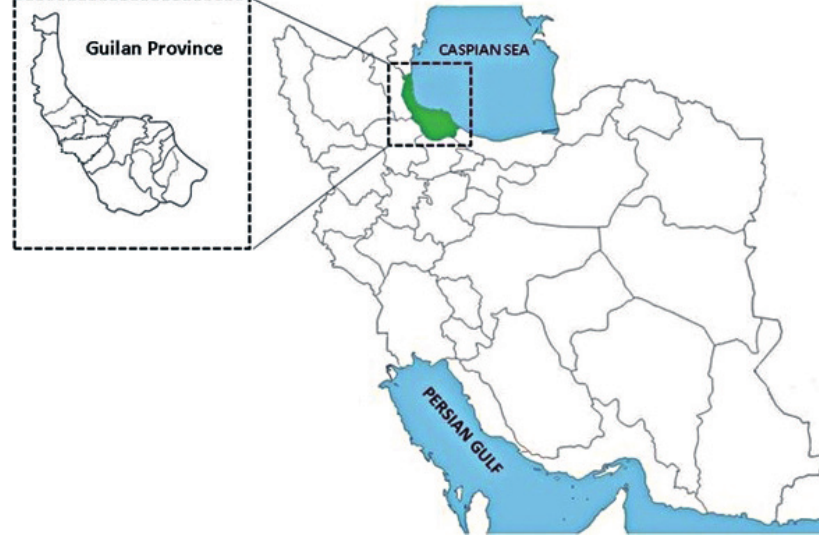
Figure 1. Map of Iran showing the geographical location of Guilan Province in northern